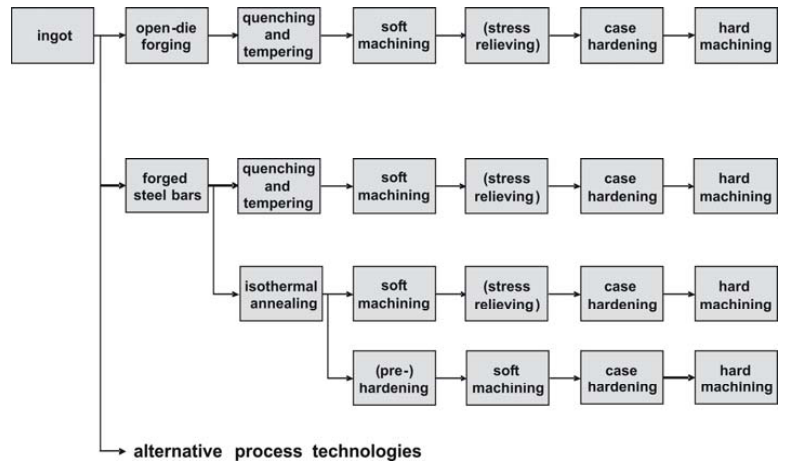
Figure 1. Typical processing routes for the manufacturing of case ‐ hardened components.